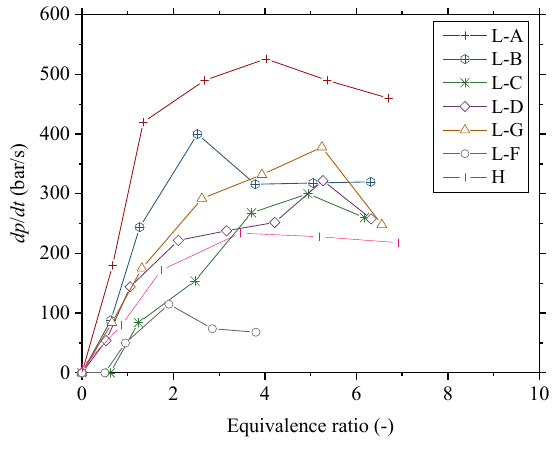
Figure 2. Rate of pressure rise versus the equivalence